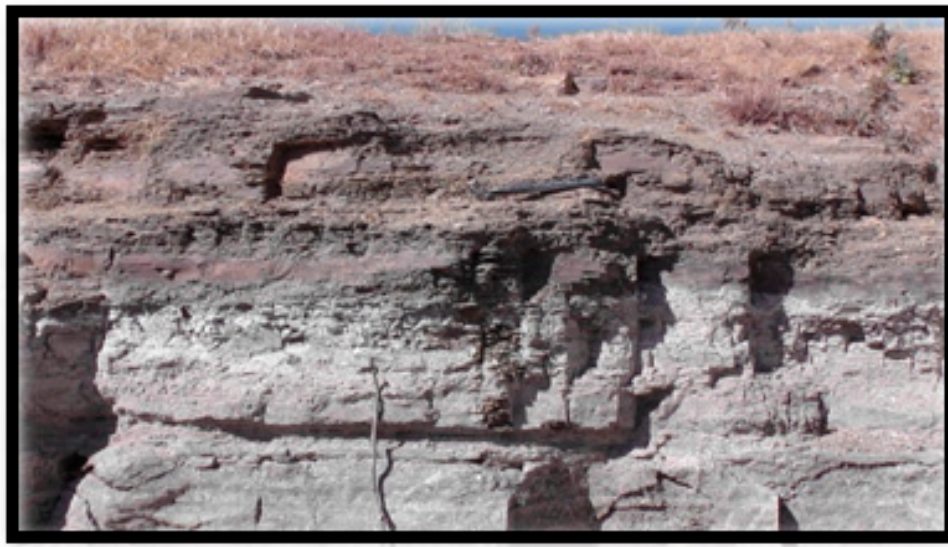
Figure 3. Exposed limestone–shale–marl intercalation in the command